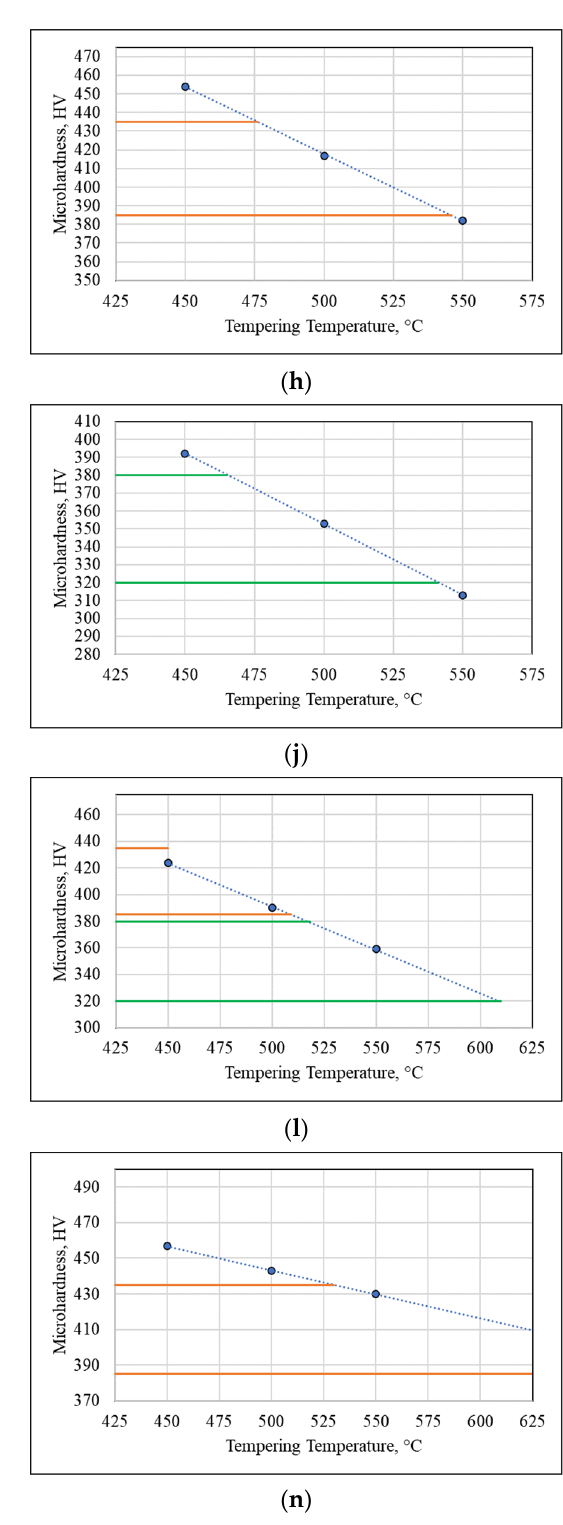
Figure 5. Dependences of the tensile strength and HV hardness on the tempering temperature of rolled products made of steel of grades: ( a , b ) 42CrMo4; ( c , d ) 32CrB4; ( e , f ) 40KhN2MA; ( g , h ) 34CrNiMo6; ( i , j ) 31CrMoB2; ( k , l ) 32KhGMR; and ( m , n ) 35KhNMFA. Orange horizontal lines correspond to the maximum and minimum values of properties for property class 12.9, green lines correspond to property class 10.9.